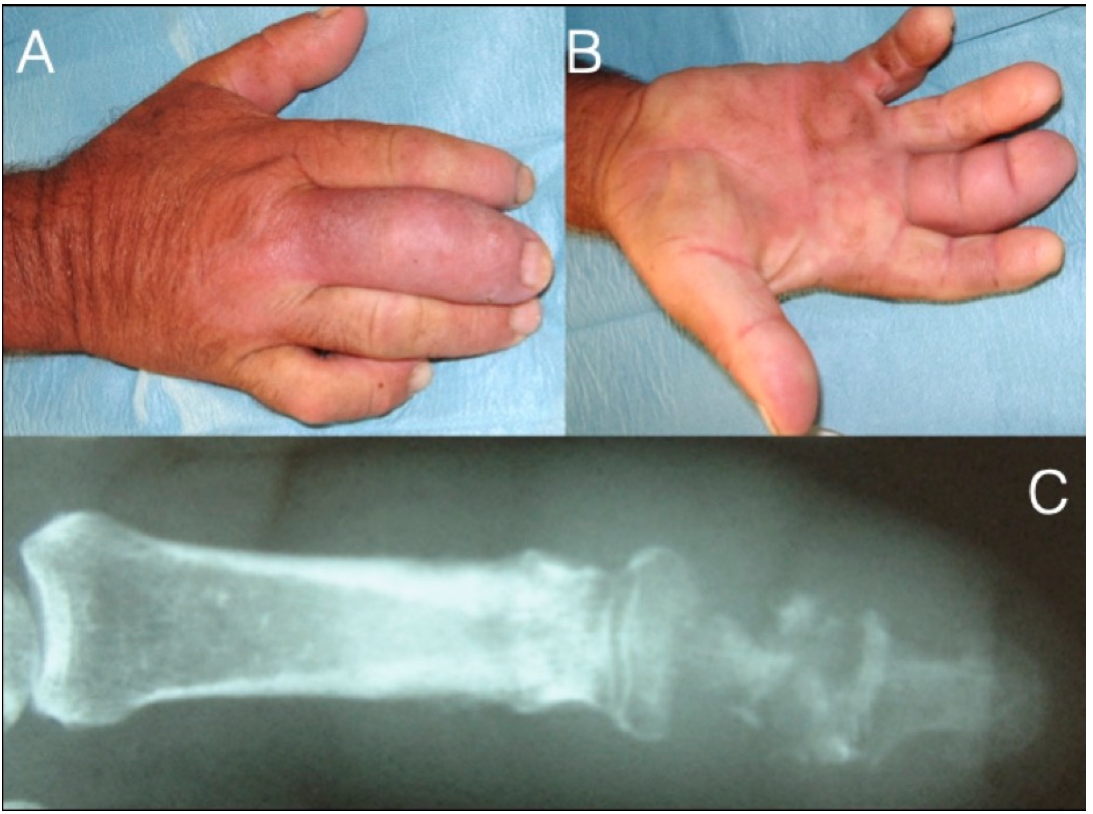
Figure 6. 71-year-old farmer with a fusiform middle finger after penetrating injury 17 days ago through the dorsal skin just proximal to the DIP joint ( A , B ). He received analgesics and ampicillin per os in the last six days. The patient developed osteomyelitis of the middle phalanx and septic arthritis of the DIP joint ( C ). After debridement he underwent amputation at the PIP joint level.